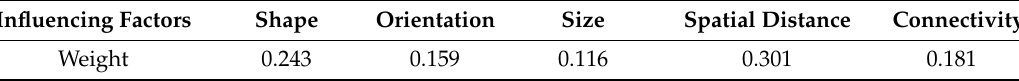
Figure 6. The clustering result obtained by human cognition on experimental region b . Table 2. Weight scheme trained by the Relief-F algorithm.